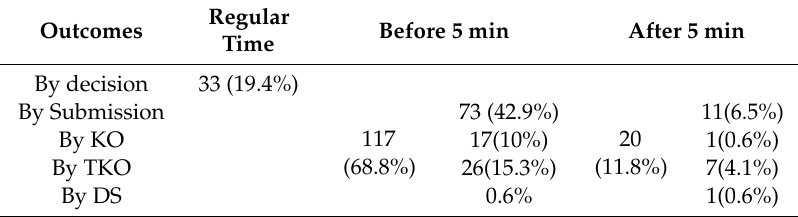
Table 1. Fight outcome characterization regarding the methods and occurrence